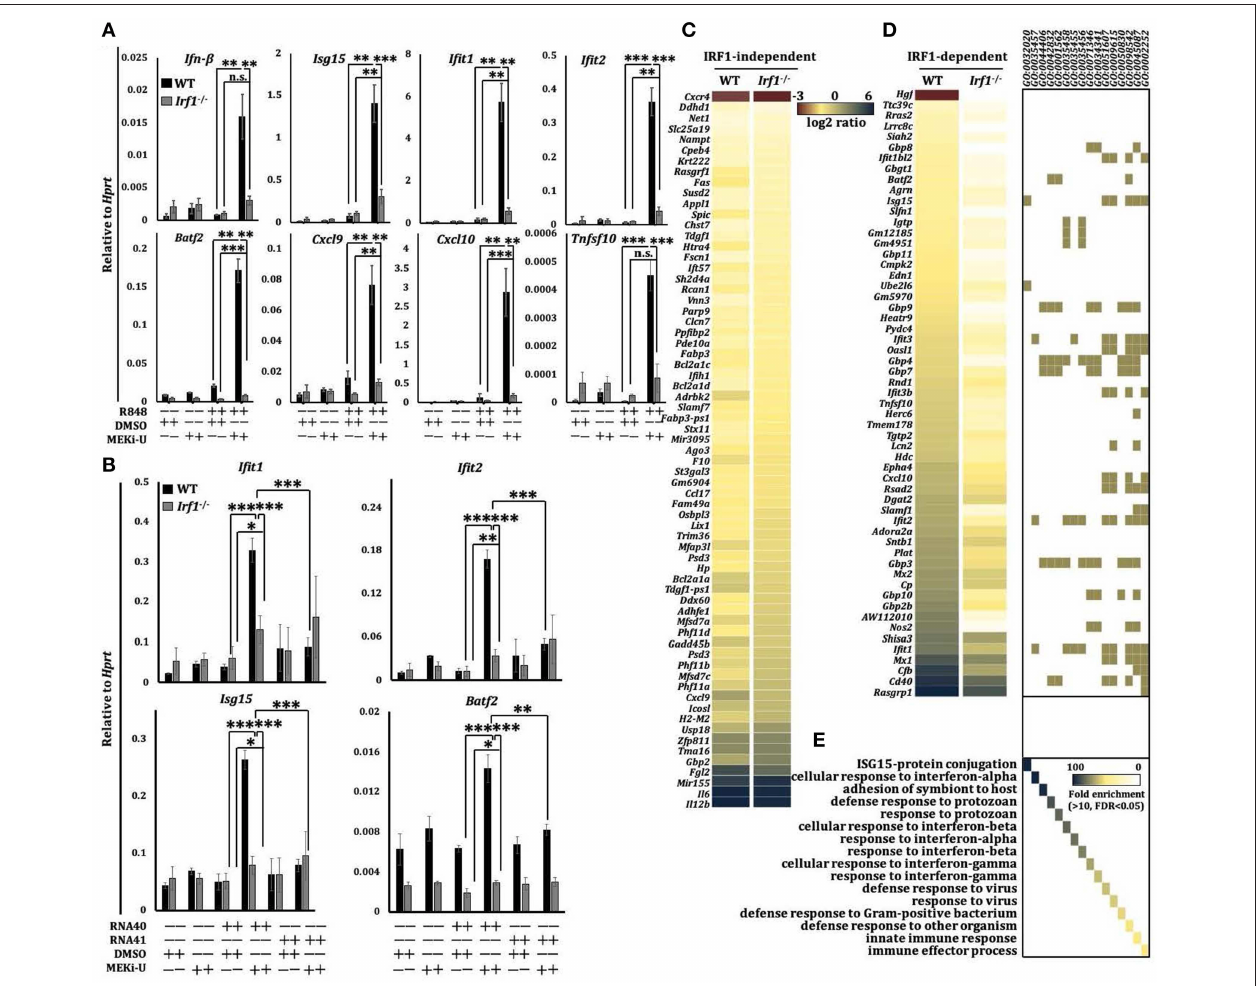
FIGURE 3 | Unlocked interferon signature response is IRF1-dependent. (A) qRT-PCR analysis of mRNA expression of the indicated interferon response genes in WT and Ifit1 − / − BMDM stimulated with TLR7 agonist R848 for 6h in the presence or absence of MEK1/2 inhibitor (MEKi-U). Data are means ± SD from 3 to